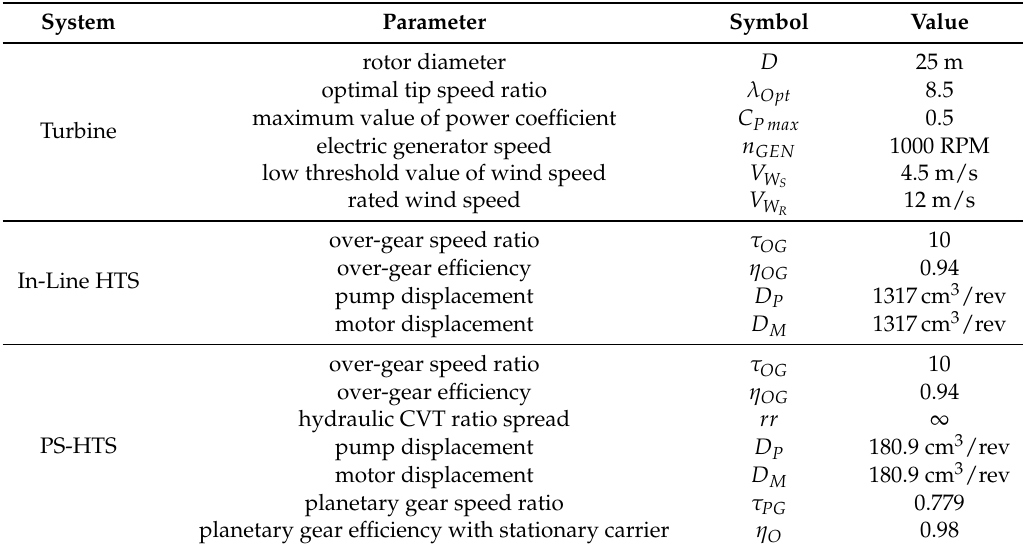
Table 1. Main parameters of the wind